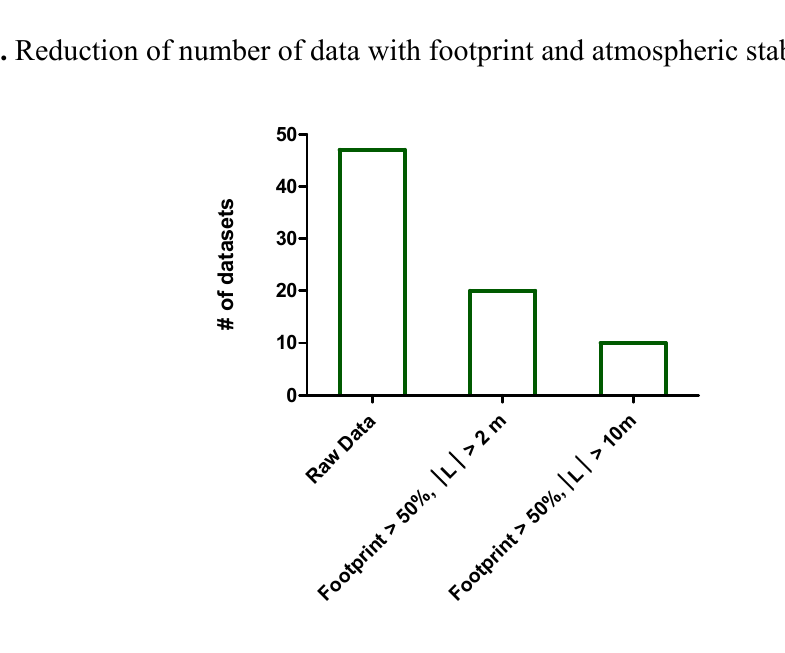
Figure 6. Accuracy of measured emission Q integrated concentration data